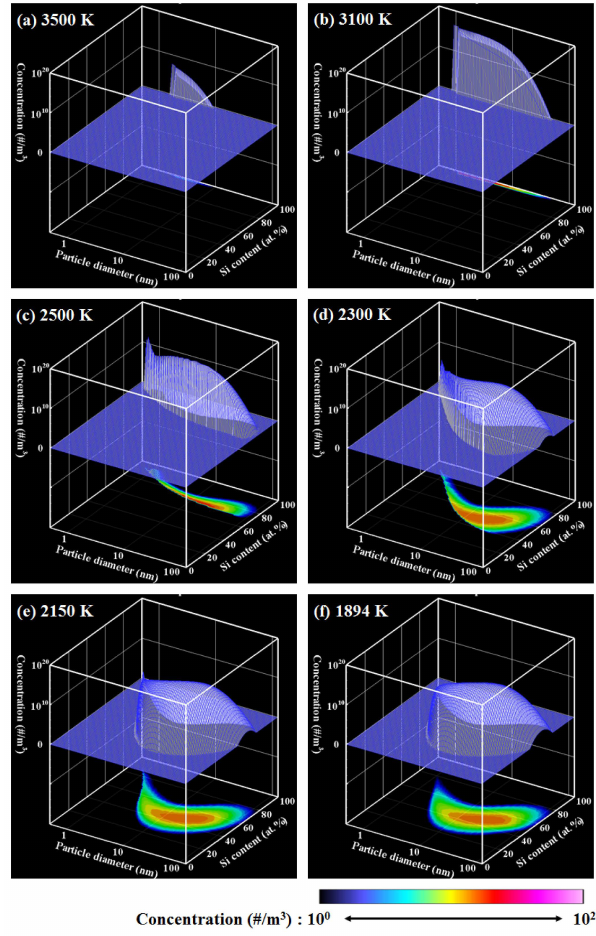
Figure 6. PSCD evolution for ζ = 10 ´ 3 .